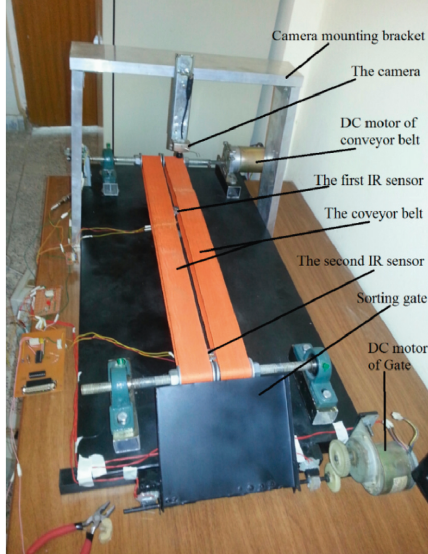
Figure 2: The main parts of the developed sorting system.